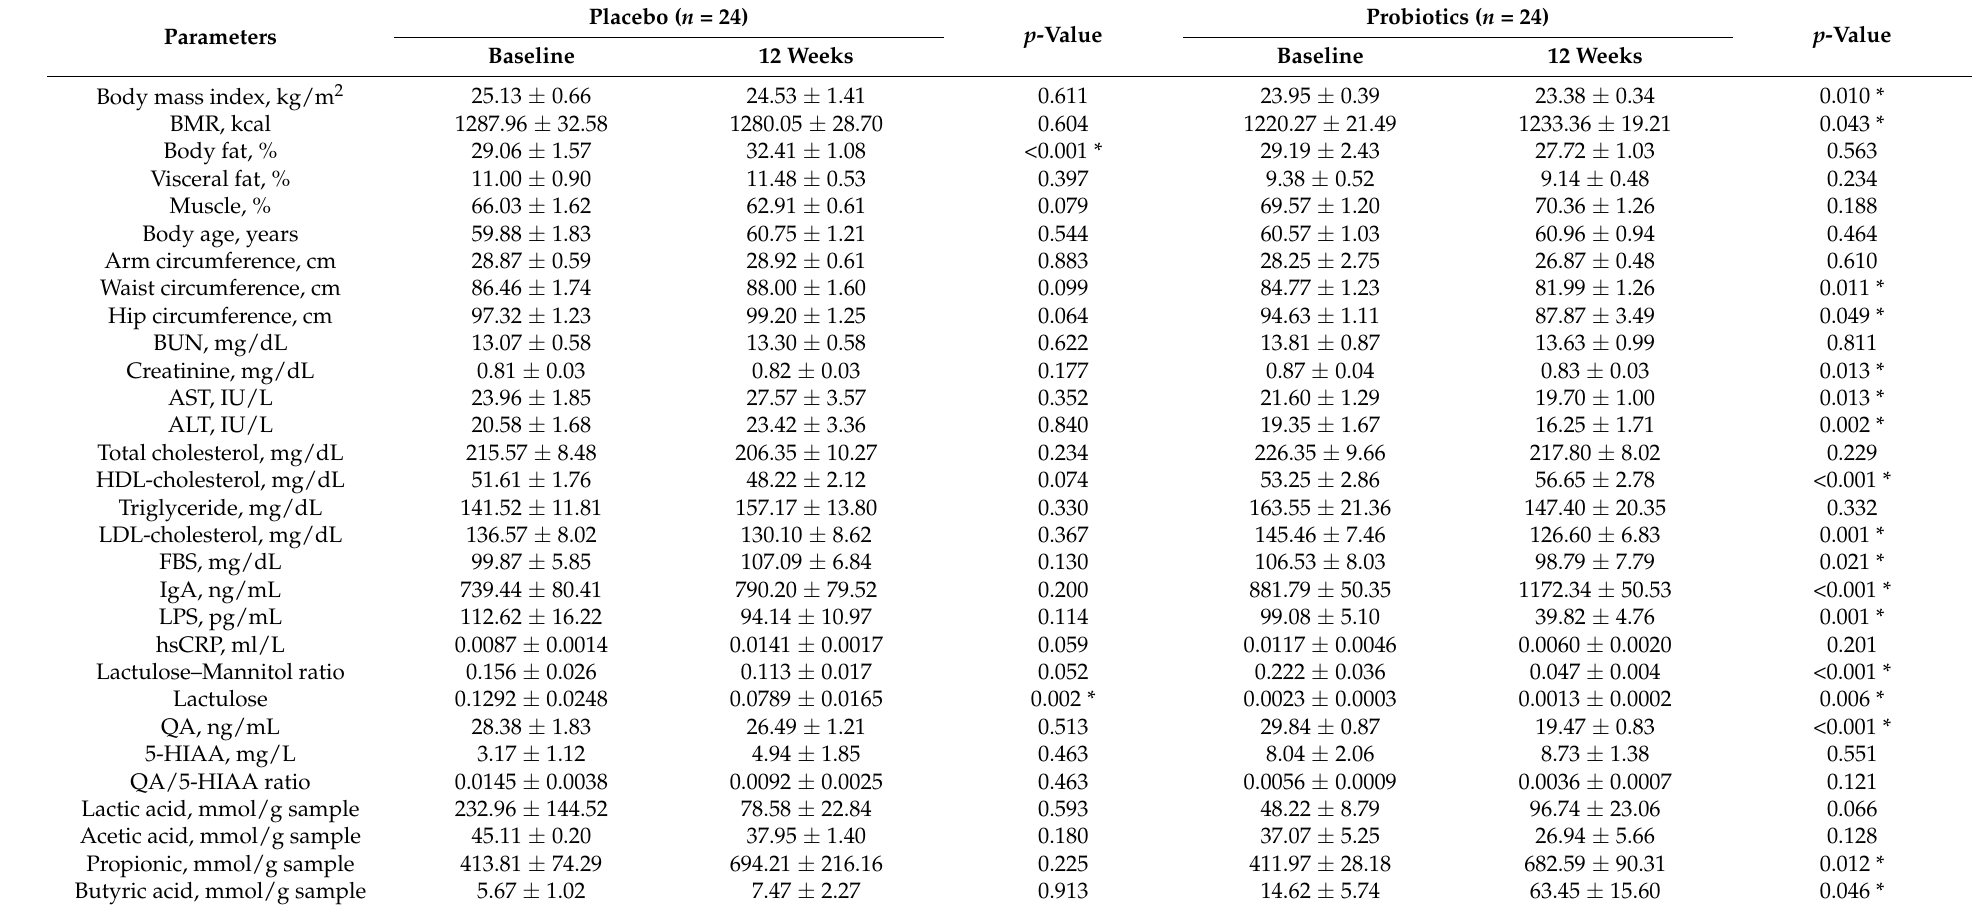
Table 2. Changes in the study parameters within-group at different times are expressed as mean ±